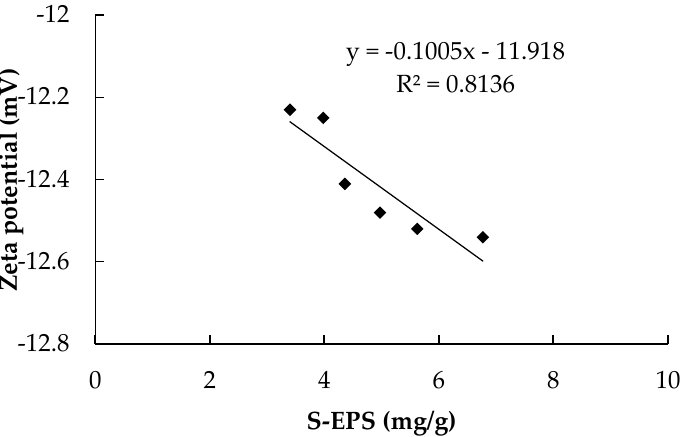
Figure 4. Relationship between soluble extracellular polymeric substances (S-EPS) and Zeta potential.